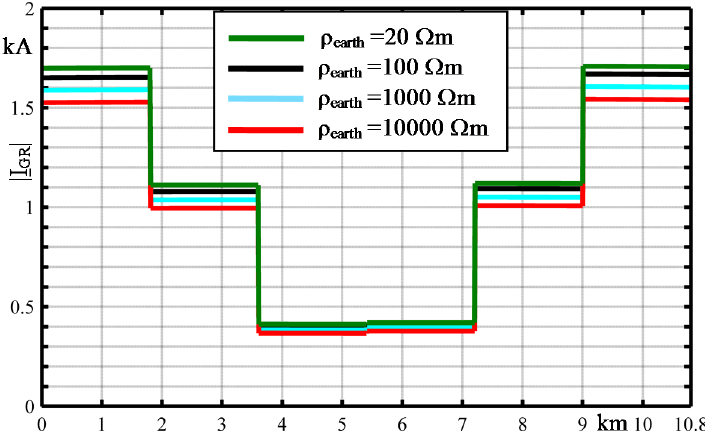
Figure 6. Faulted UGC: ground return current magnitudes along the line (CB with PTs) for different earth resistivities; FAULT at midline.